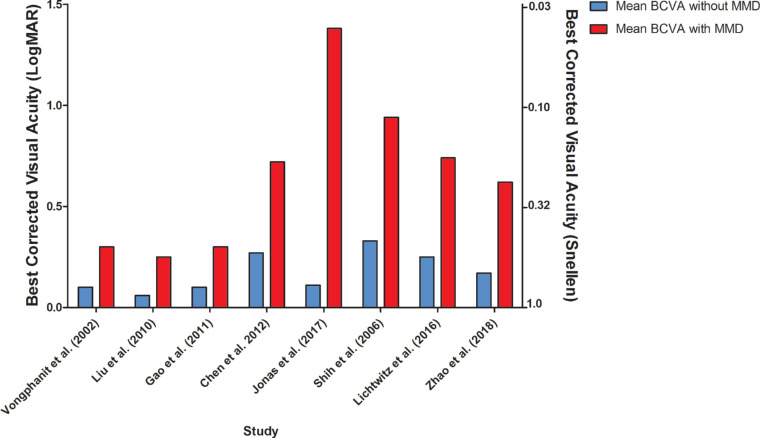
BCVA in eyes with and without MMD.